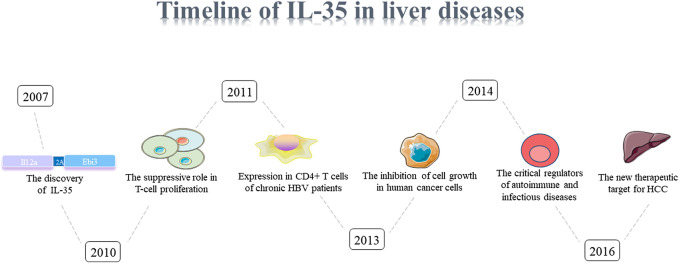
Timeline of IL-35.